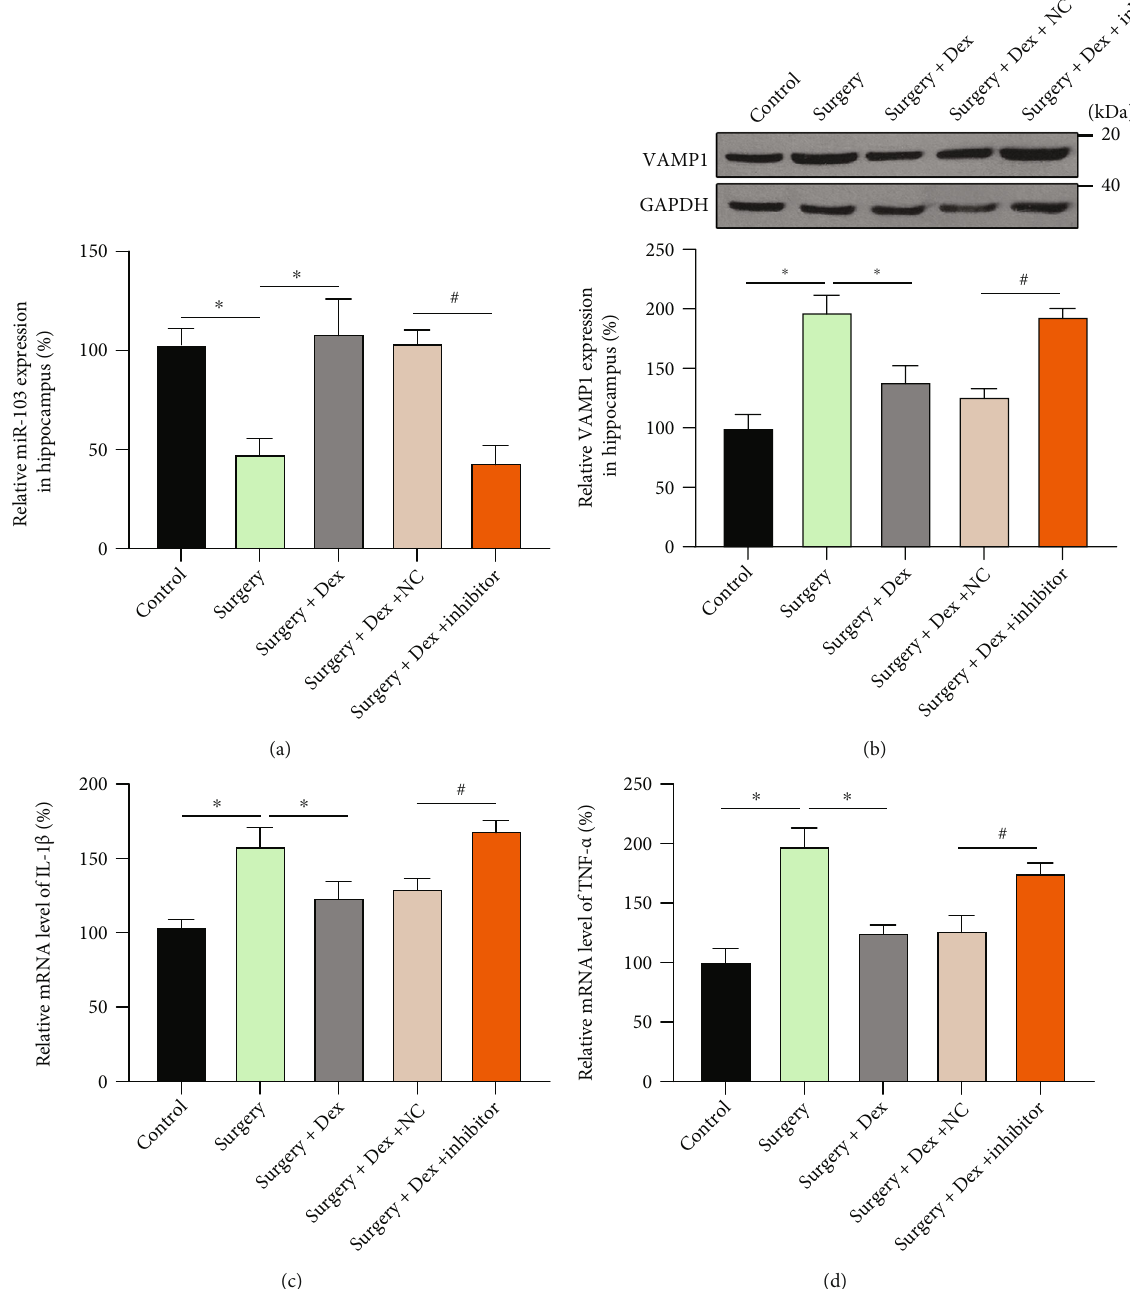
Figure 6: Dexmedetomidine alleviates surgical trauma-induced microglial activation in vivo . Rats were treated with or without dexmedetomidine (Dex) and an exogenous miR-103a-3p inhibitor. (a) miR-103a-3p expression was detected by qRT-PCR. (b) VAMP1 protein expression in the hippocampus was detected by immunoblotting; mRNA expression levels of IL-1 β (c) and TNF- α (d) were determined in the hippocampus (Sham as control, 3 animals for each group, n =3 repeated experiments). Two tailed t -test, ∗ , # p < 0 : 05